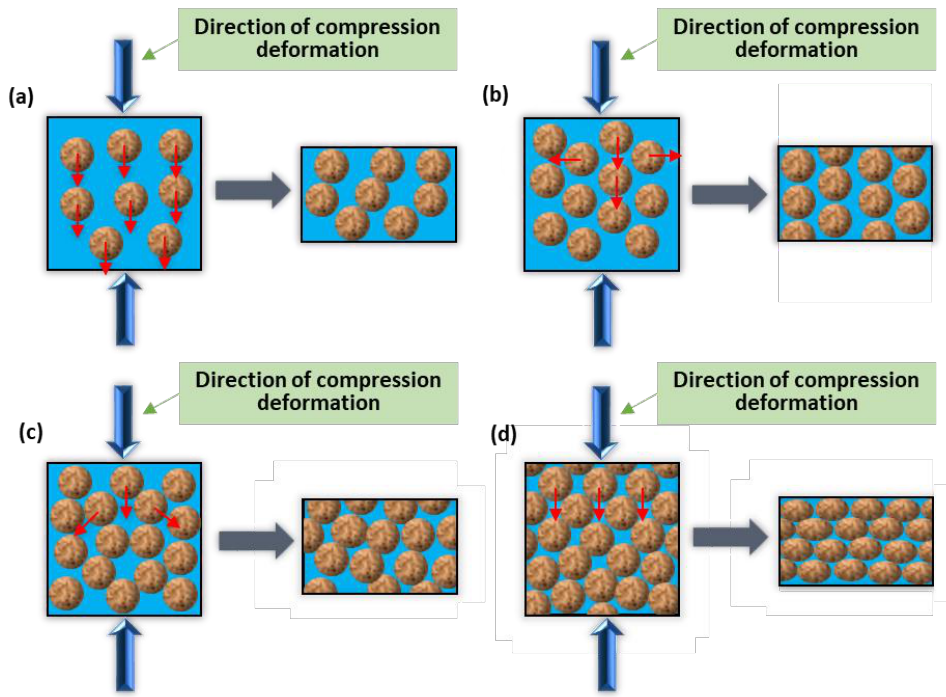
Figure 13. Schematic diagram of deformation mechanisms: ( a ) Liquid phase flow, ( b ) solid grains slip or rotate along the liquid film, ( c ) slipping among solid grains, and ( d ) plastic deformation of solid